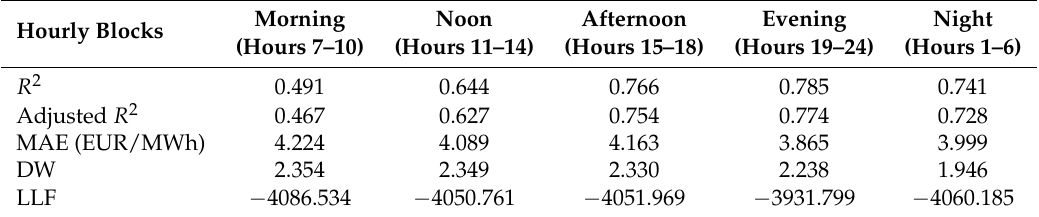
Table 7. Goodness of fit, for morning, noon and afternoon hourly blocks for working days, including renewable energies wind and PV.